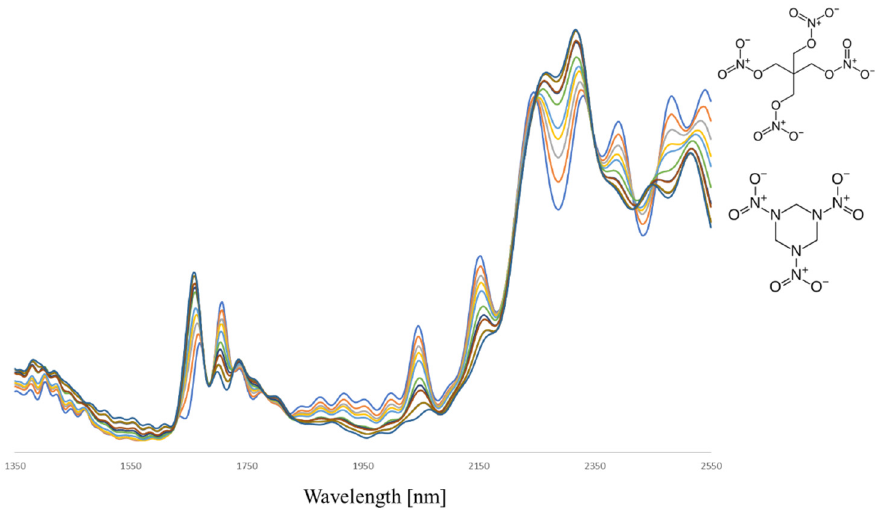
Figure 7. SNV-corrected, average NIR spectra (n = 5) of binary mixtures of RDX and PETN in different weight ratios (from 100% RDX to 100% PETN in steps of 10 wt%).